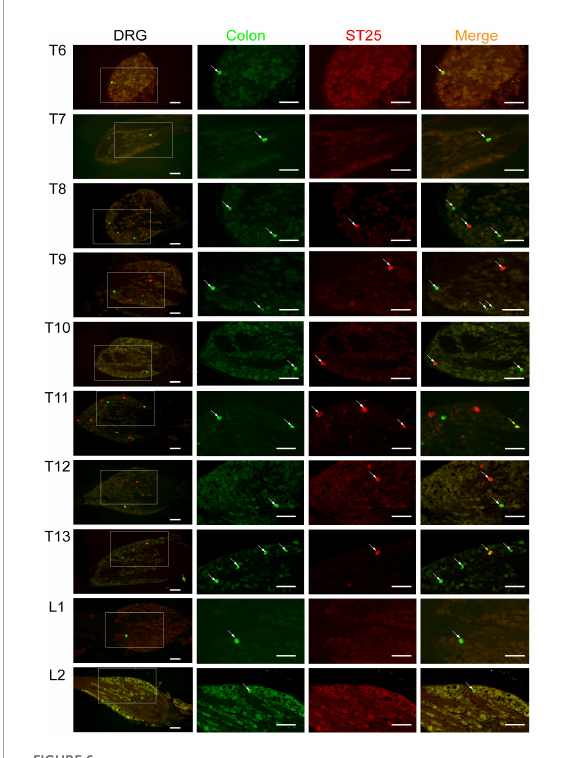
FIGURE6 The neural tracing of the colon and ST25 in the dorsal root ganglia (DRGs) (sectioned). Representative and magnified photomicrographs showing the distribution of AF488/594-CTB-labeled sensory neurons in the T6–L2 DRGs. The double-labeled neurons with AF488/594-CTB presenting in yellow. Scale bars = 100 µ m.